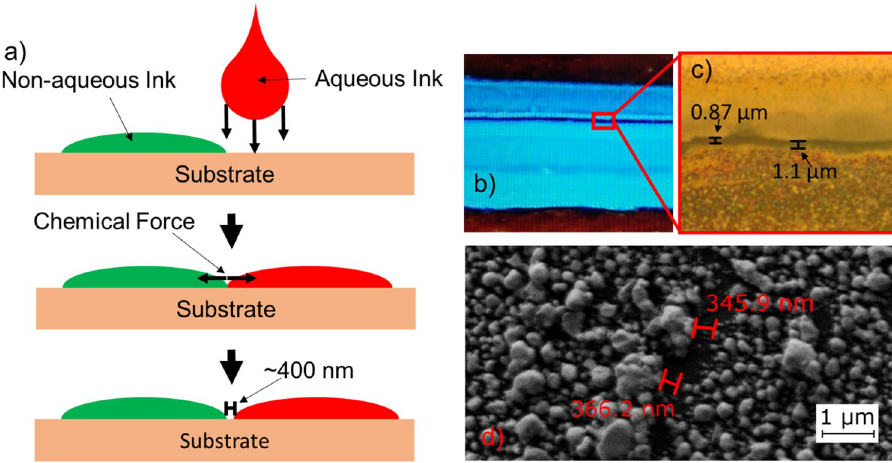
Figure 3. ( a ) Illustration of the chemical forces between the inks. A small gap can be accomplished with any ink pairing with opposing chemistries, not just silver nanoparticle solutions. ( b ) Two parallel lines forming a chemical gap. The lines are electrically isolated. ( c ) A zoomed in image of an average chemical gap. Results like this were observed across multiple devices. ( d ) SEM photograph taken at 16880 × magnification of the smallest observed electrically isolated